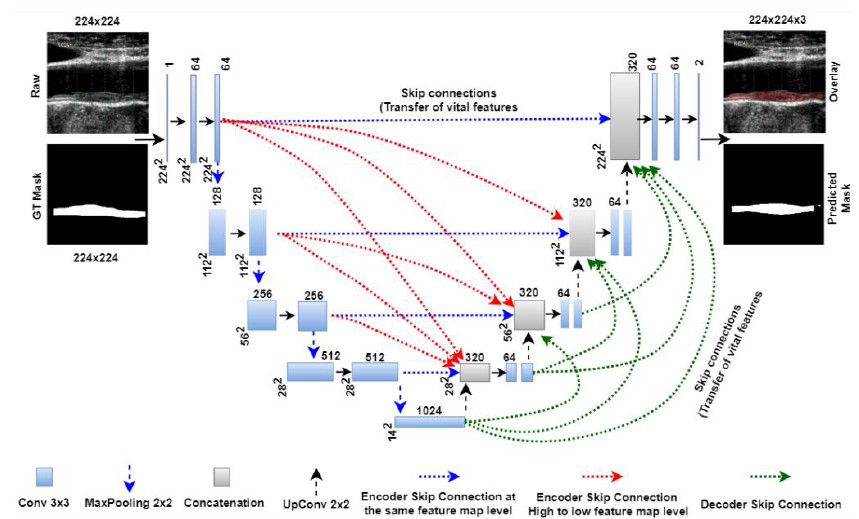
Figure A3. UNet++ Architecture. Figure A2. UNet++